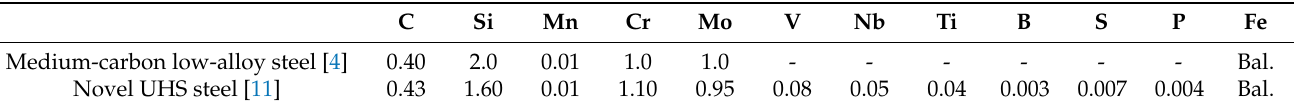
Table 1. Chemical composition of the medium-carbon low-alloy steel and novel UHS steel (weight percentage). C Si Mn Cr Mo V